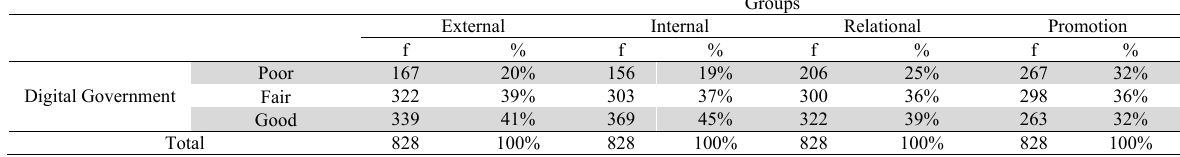
Digital Government